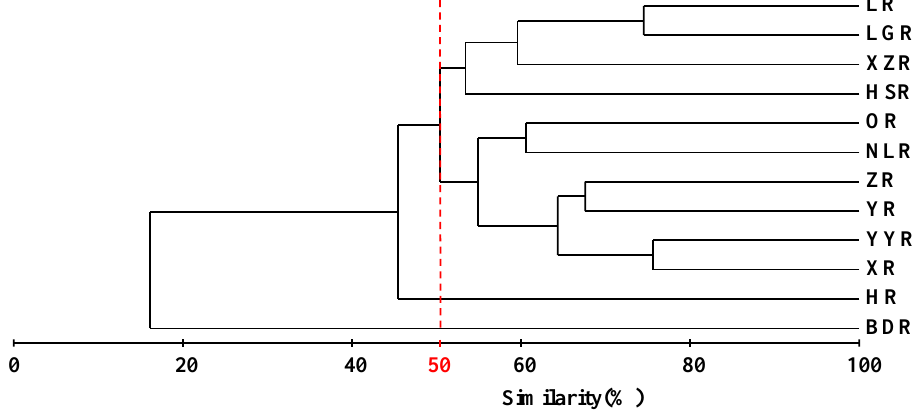
Figure 6. Cluster analysis of 12 Sub − basins of freshwater fish data for Guangxi based on the Jaccard similarity matrix and group average clustering method. Sub − basin codes are described in Table 1.